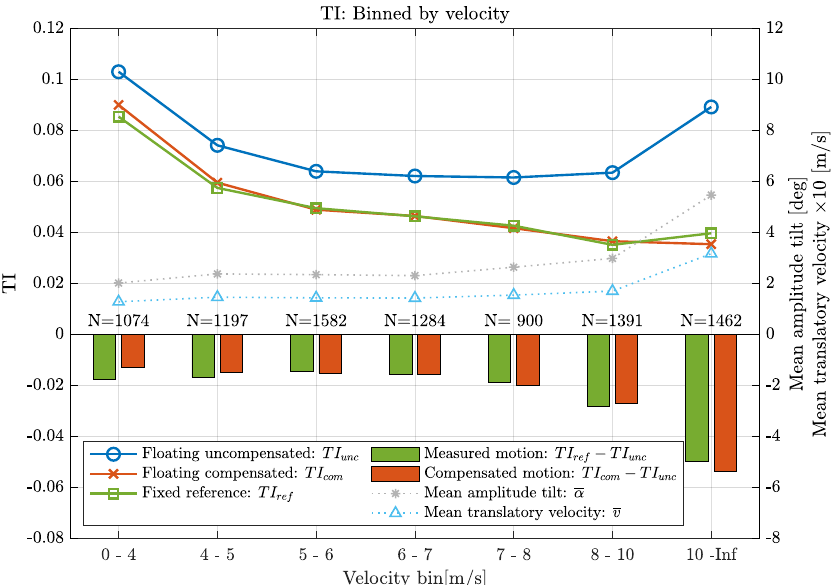
Figure 9. TI from all measurement heights binned by mean wind velocity. Legend as in Figure 8 plus markers for the mean tilt amplitude α and mean translational velocity v that scale with the right hand side y